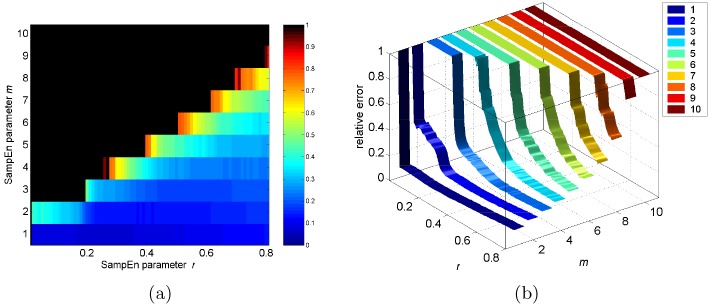
A visual guide to optimal selection of window length (m) and tolerance (r) parameters for SampEn estimation of fMRI time series of length 128.(a) the median value of relative error of SampEn is shown in pseudocolor. (b) their changes with m and r is shown as a color ribbon map.